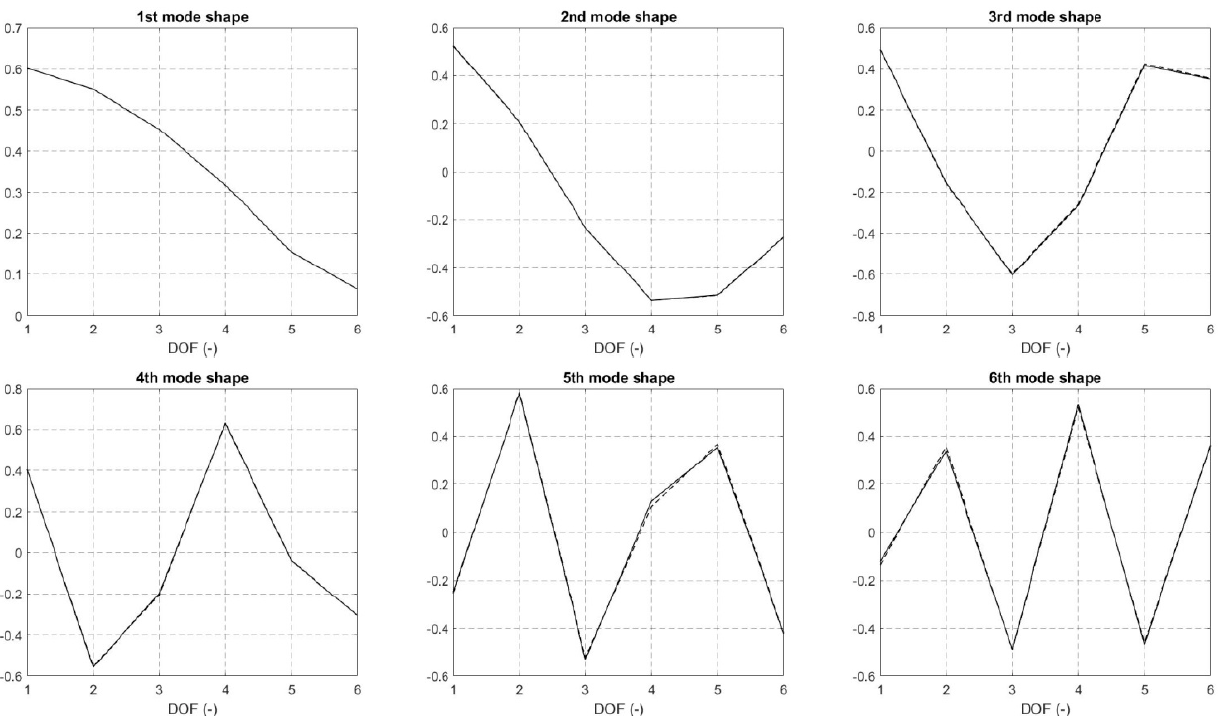
Figure 7. Mode shapes of six-DOF chain model of a cantilever beam (the solid line is an analytic solution, the dotted line is ERA/DC identification result).